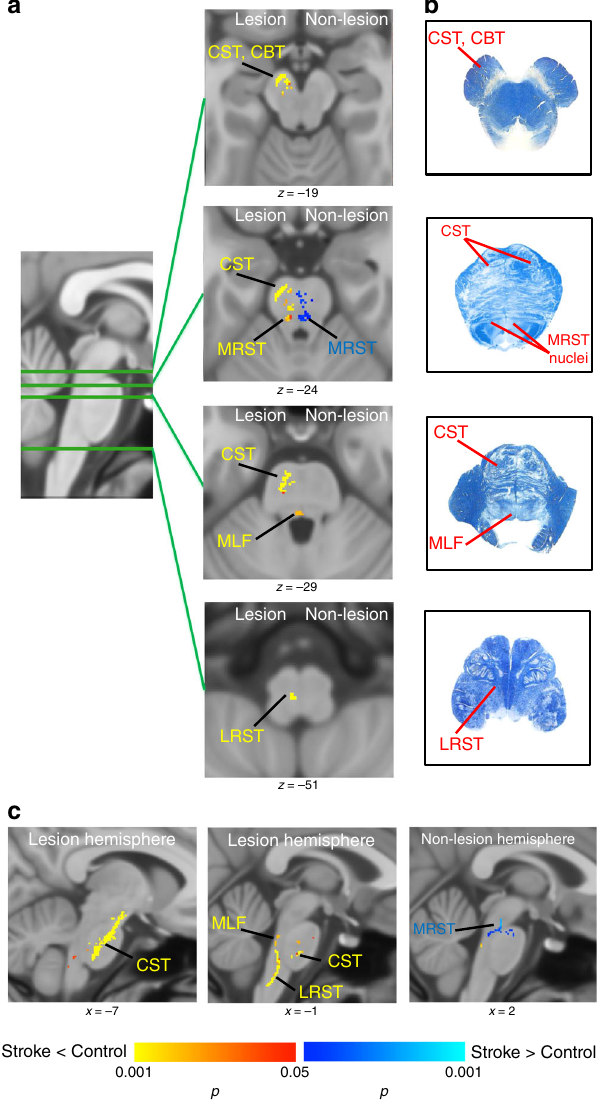
Fig. 1 Tracts with white matter integrity changes in brainstem in individuals with stroke compared to controls. a Axial view of the tracts with signi fi cant decrease (red-yellow) or increase (blue) in white matter integrity in individuals with stroke compared to controls. Corticospinal tract (CST), corticobulbar tract (CBT), medical reticulospinal tract (MRST), lateral reticulospinal tract (LRST), and medial longitudinal fasciculus (MLF) of the lesioned hemisphere showed signi fi cant decreased white matter integrity in individuals with stroke compared to controls. Medial reticulospinal tract (MRST) of non-lesioned hemisphere showed signi fi cant increased white matter integrity in individuals with stroke. b Brainstem atlas adapted from Gray ’ s anatomy and Haines ’ neuroanatomy with modi fi cation for simplicity, showing the location of tracts. c Sagittal view of the tracts with signi fi cant decrease (red-yellow) or increase (blue). (Statistical test: two-sample t test with non-parametric 50,000 permutation. Using the threshold-free cluster enhancement with corrected p <